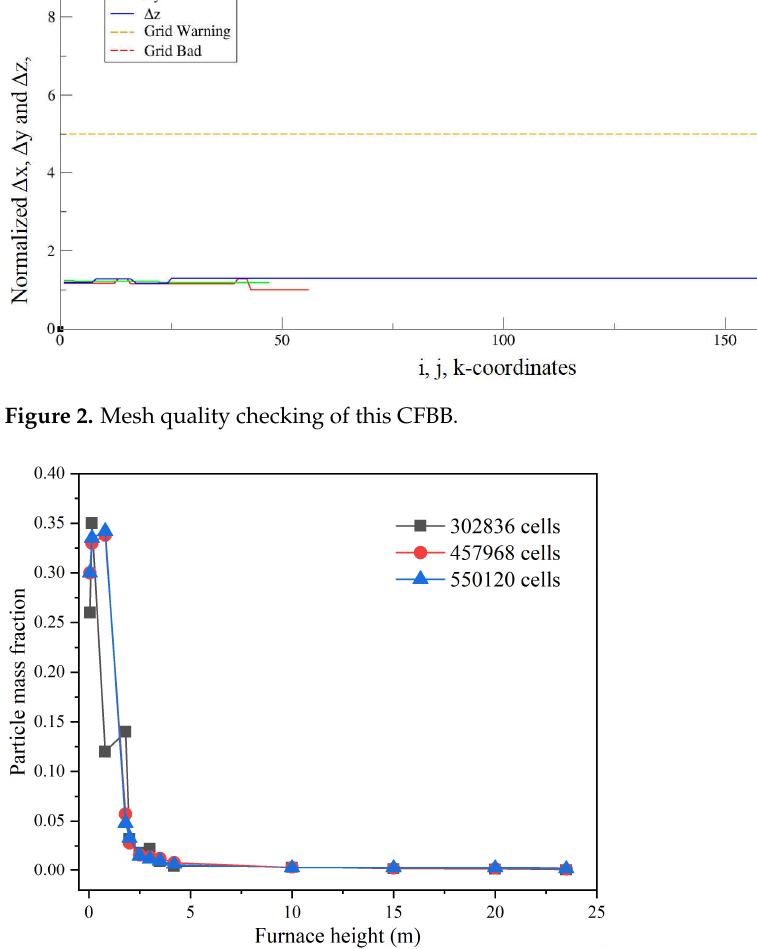
Figure 3. Mesh independence verification of this CFBB.